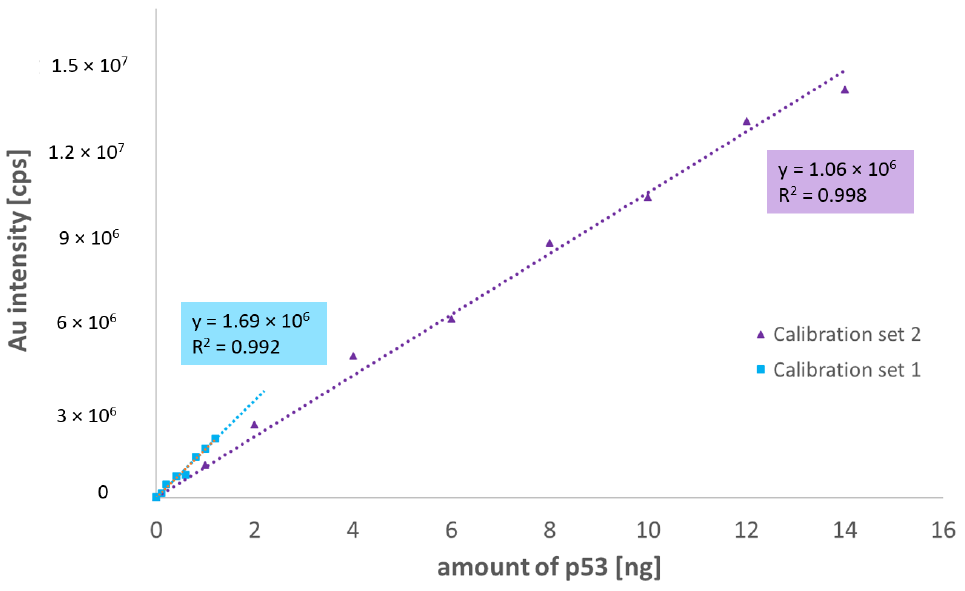
Figure 6. p53 calibration curves 0.1–1.4 ng—blue, 1–14 ng—purple .